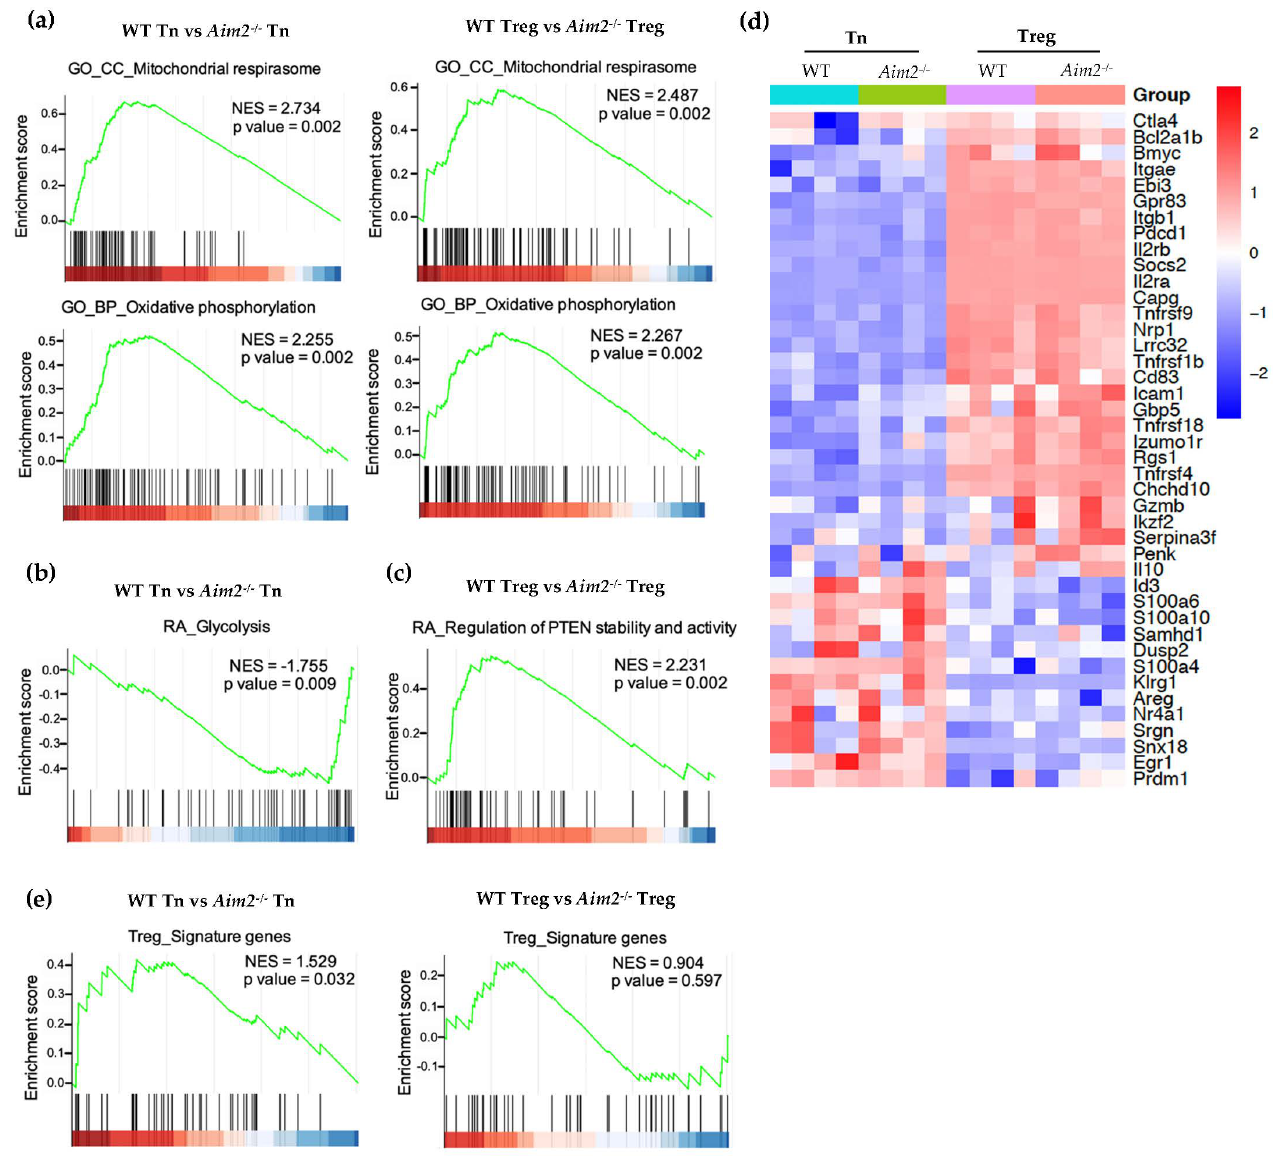
Figure 3. RNAseq analysis in naïve T cells and during Treg polarization conditions. ( a – c ) Gene set enrichment analysis (GSEA) of CD4 + naïve T cells (Tn) from WT and Aim2 −/− and from WT and Aim2 −/− T cells stimulated under Treg polarizing conditions (Treg) for 2 days ( n = 4/group). GO = gene ontology database; CC = cellular component; BP = biological process; NES = normalized enrichment score; RA = reactome database. ( d ) Heatmap showing the expression of Treg-associated genes in Tn and Treg from WT and Aim2 −/− mice ( n = 4/group). Color coded values represent log2 values of the normalized counts, mean-centered for each gene. ( e ) GSEA analysis of Treg-associated genes in Tn (left) and Treg (right) cells from WT and Aim2 −/− mice ( n = 4/group).